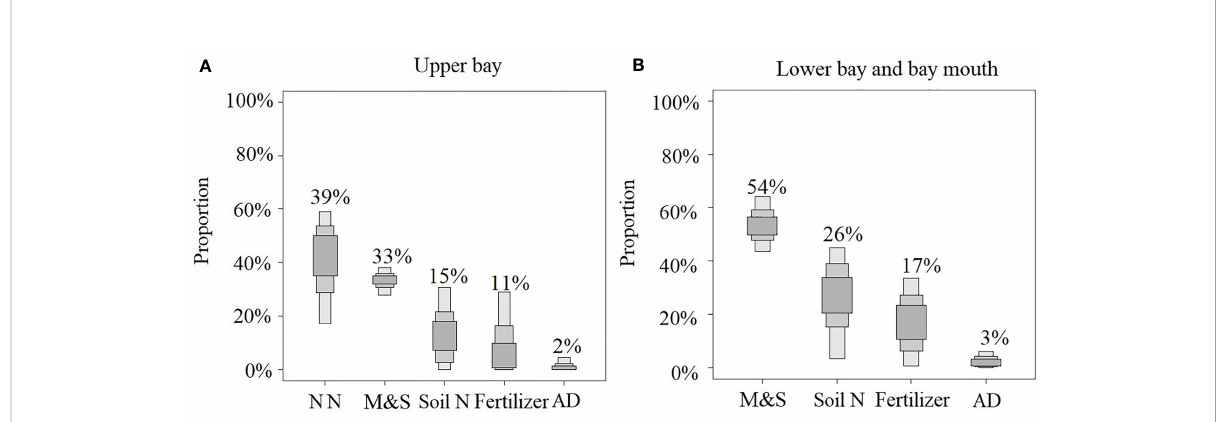
FIGURE 8 Proportion of potential nitrate sources in bay A during rainy season. (A) Proportion of potential nitrate sources in Upper bay, (B) Proportion of potential nitrate sources in Low bay and bay mouth. NN: nitrate from nitri fi cation.